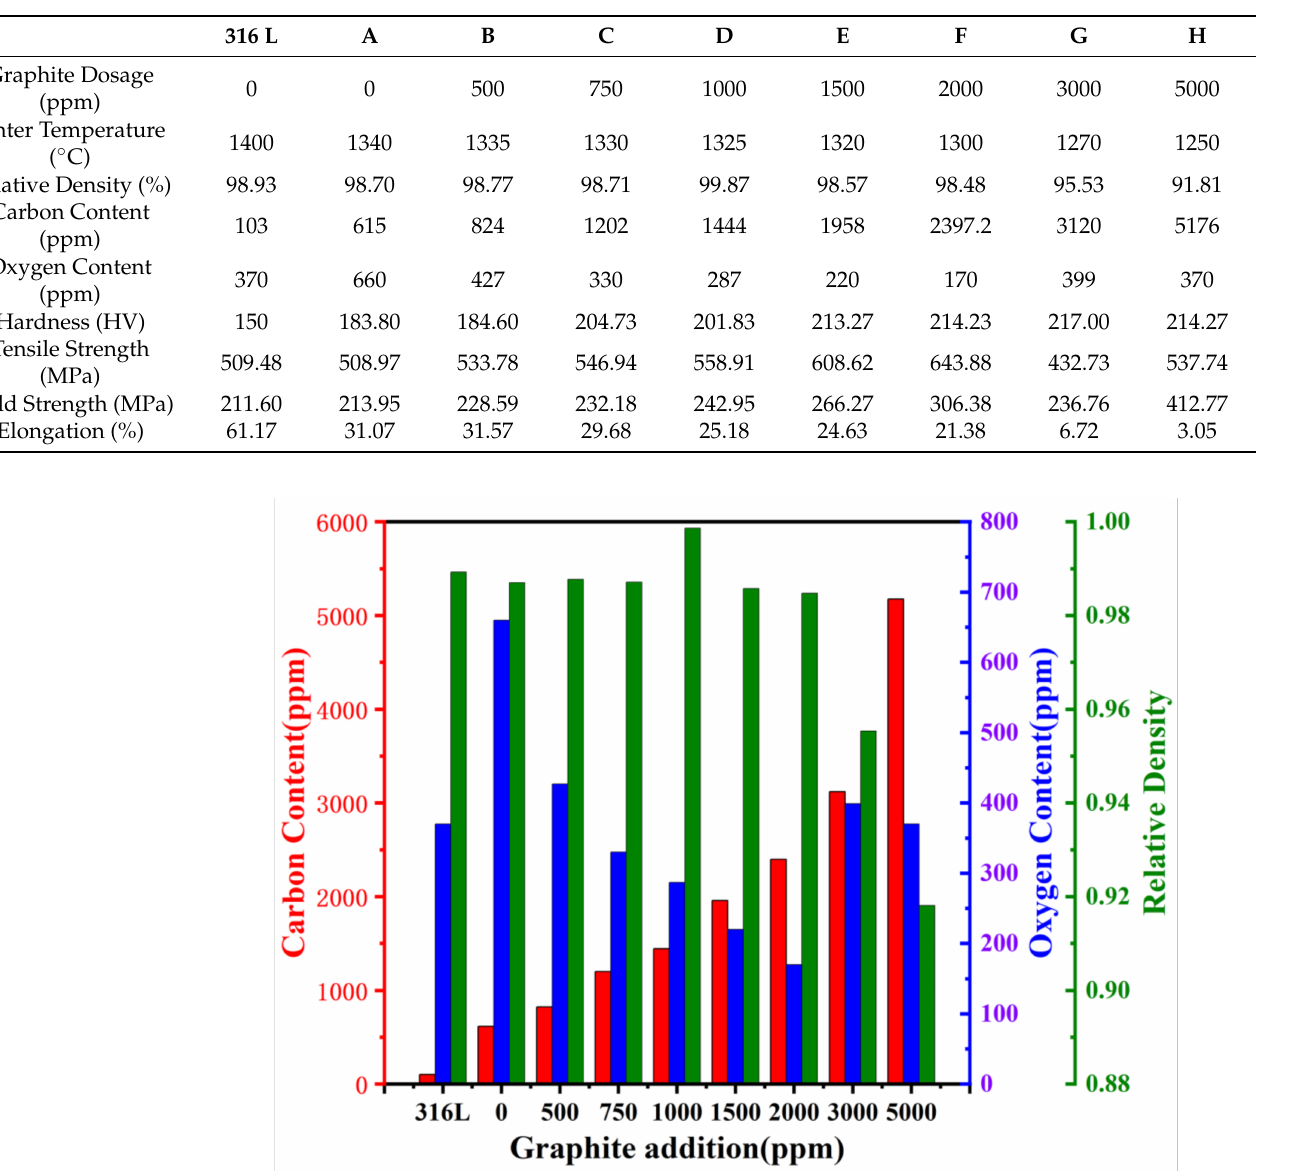
Table 2. Properties of stainless steel samples.